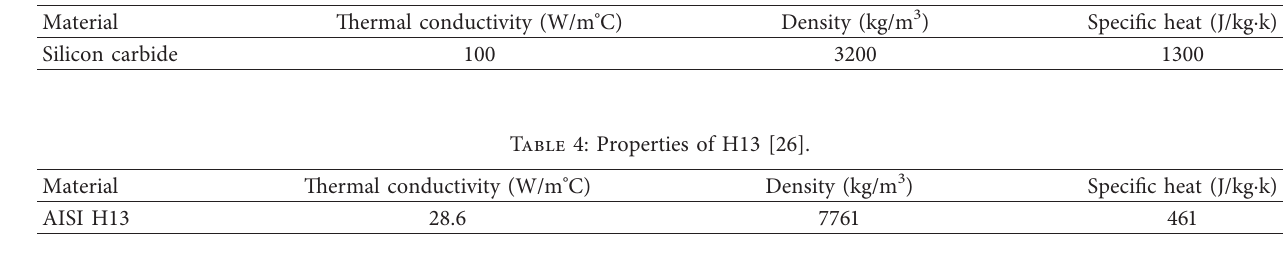
Table 3: Properties of SiC [9].